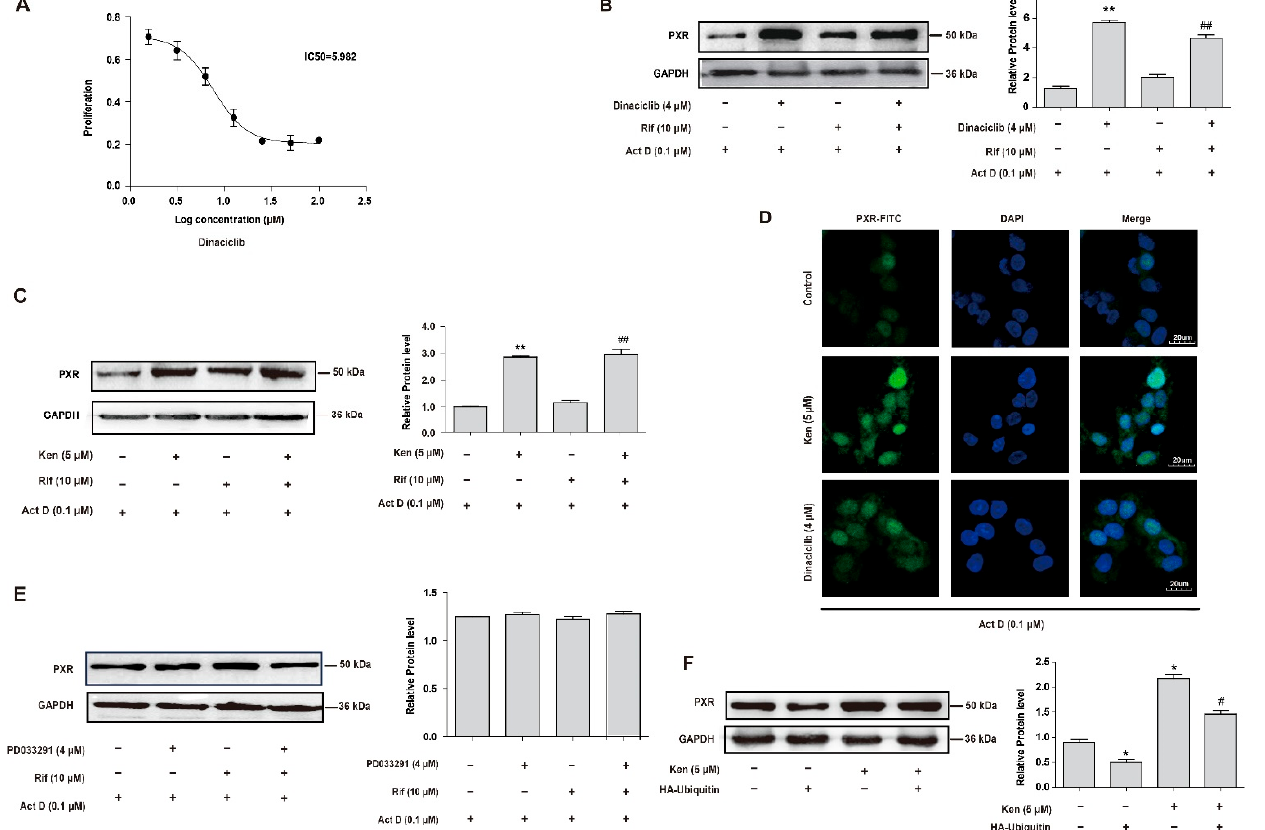
Figure 2. Inhibition of CDKs increases the protein level of PXR by suppressing its ubiquitination. ( A ) The cytotoxicity of dinaciclib in HepG2 cells. Hepatocytes were treated with indicated concentrations of dinaciclib for 24 h, and MTT assay was used to measure cell viability. ( B – E ) The effect of CDKs inhibitors on PXR protein stabilization in HepG2 cells. ( B ) Cells were treated with dinaciclib (4 μ M) in the presence of actinomycin D (0.1 μ M) with or without rifampicin (10 μ M) for 24 h. ( C ) HepG2 cells were treated with kenpaullone (Ken, 5 μ M) in the presence of actinomycin D (0.1 μ M) with or without rifampicin (10 μ M) for 24 h. ( D ) HepG2 cells were treated with kenpaullone (5 μ M) or dinaciclib (4 μ M) in the presence of actinomycin D (0.1 μ M) for 24 h, and fluorescence intensity of PXR was detected by immunofluorescence analysis. ( E ) HepG2 cells were treated with PD033291 (4 μ M) in the presence of actinomycin D (0.1 μ M) with or without rifampicin (10 μ M) for 24 h. PXR protein levels were investigated by Western blot. ( F ) HepG2 cells were transfected with HA-ubiquitin for 24 h and then treated with or without kenpaullone (5 μ M) for 24 h. PXR protein levels were investigated by Western blot. Experiments described in this figure were repeated independently at least three times, and data are ex- pressed as mean ± SEM ( n = 3). * p < 0.05, ** p < 0.01 versus control; # p < 0.05 versus HA-ubiquitin overexpression group, ## p < 0.01 versus rifampicin-treated group. 3.3. The Attenuated Interaction of PXR with DNAJC7 and Hsp90 Is Engaged in PXR Degrada- tion by CDKs The cytoplasmic CAR retention protein (DNAJC7) had been shown to maintain the cytoplasmic localization of CAR and PXR by forming a complex with the NRs and Hsp90 [16,38]. Therefore, we investigated whether the formation of a complex with PXR, Hsp90 and DNAJC7 in the cytoplasm plays a role in CDK-promoted PXR degradation. Immuno- precipitation with the specific anti-PXR, anti-Hsp90 and anti-DNAJC7 antibody revealed that the CDK inhibitors significantly promoted the association of PXR with Hsp90 and DNAJC7. The formation of the PXR-Hsp90-DNAJC7 complex was increased after the treatments with kenpaullone (5 μ M) and dinaciclib (4 μ M) (Figure 3A,B) respectively, which suggested that CDKs dissociated PXR from the complex with DNAJC7 and Hsp90, and subsequently promoted PXR degradation.